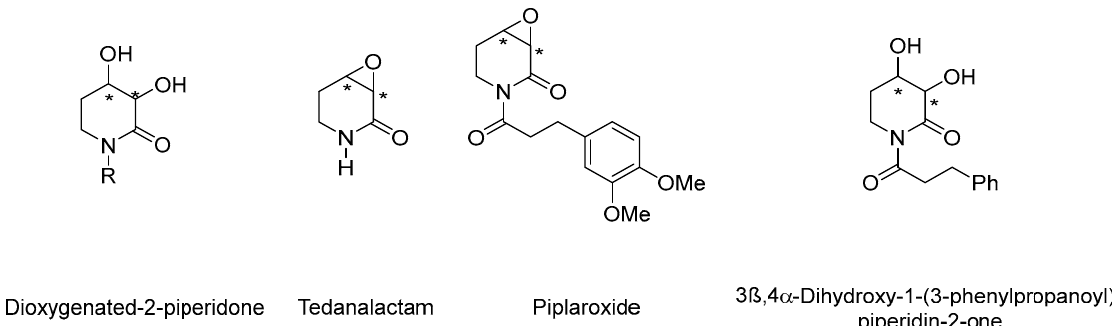
Figure 1. Representative natural products containing the dioxygenated-2-piperidinone motif; where * represents chiral center